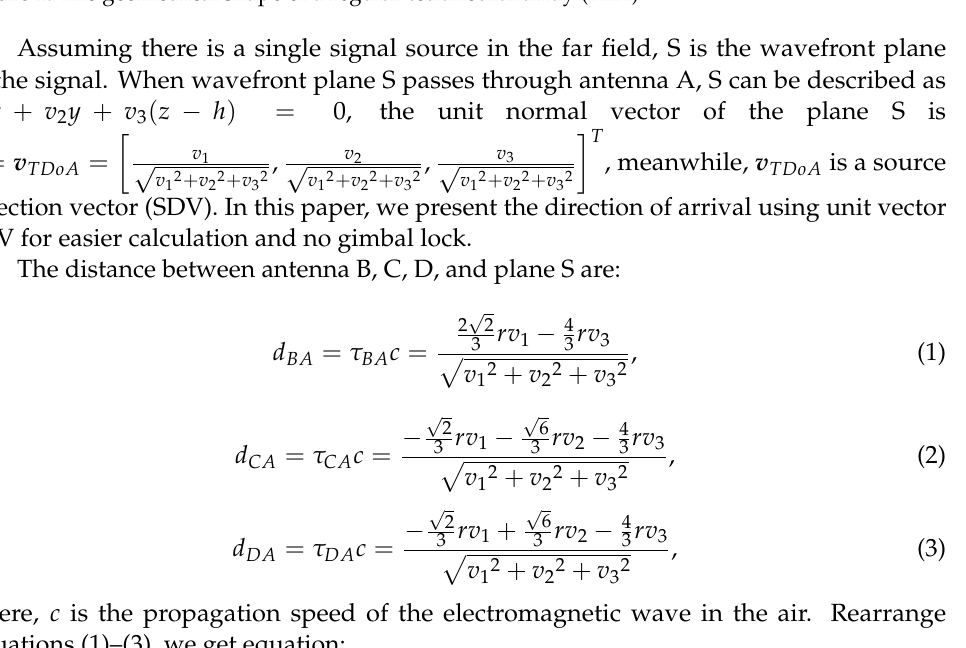
Figure 1. The geometrical shape of a regular tetrahedral array